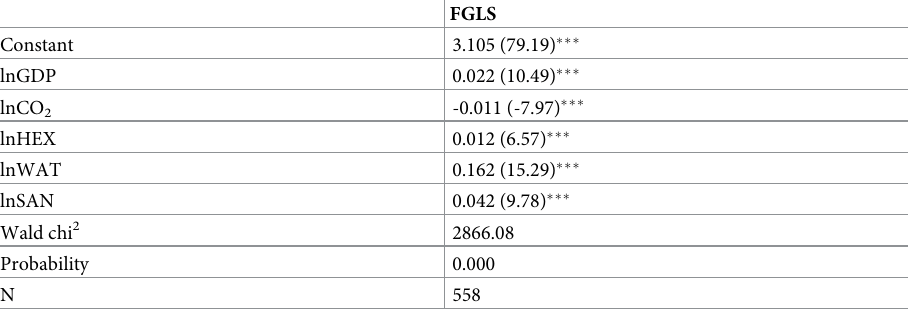
Table 5. Robustness check: The results of FGLS regression.